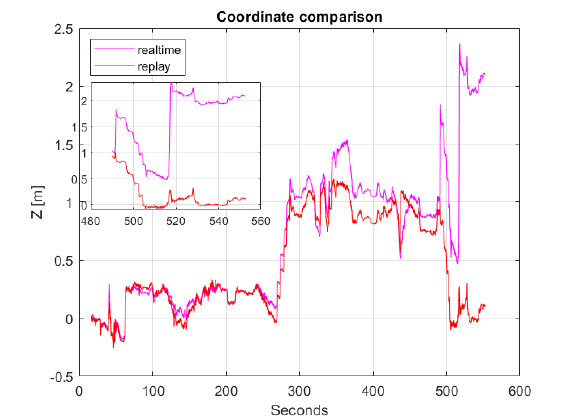
Figure 6. Z component of the estimated solution during the movement.